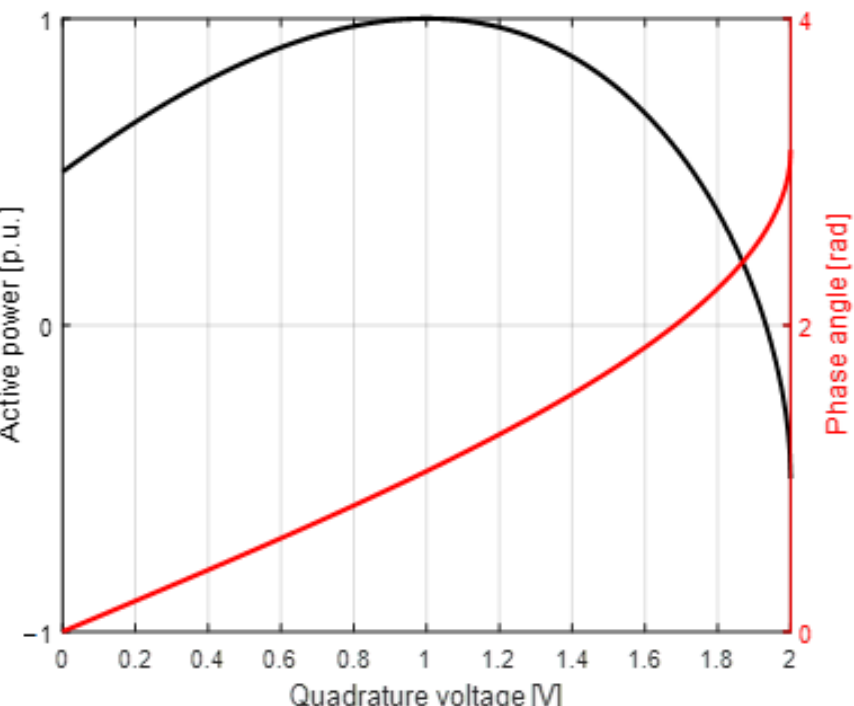
Figure 2. SPST active power flow and angle versus injected quadrature voltage.